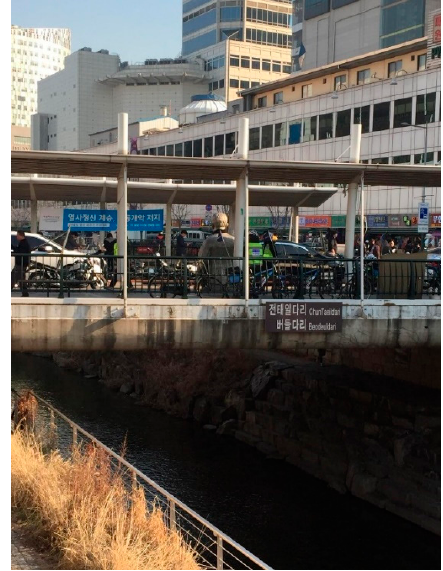
Figure 17. Chun Tae-il Bridge/Beodeuldari Bridge.